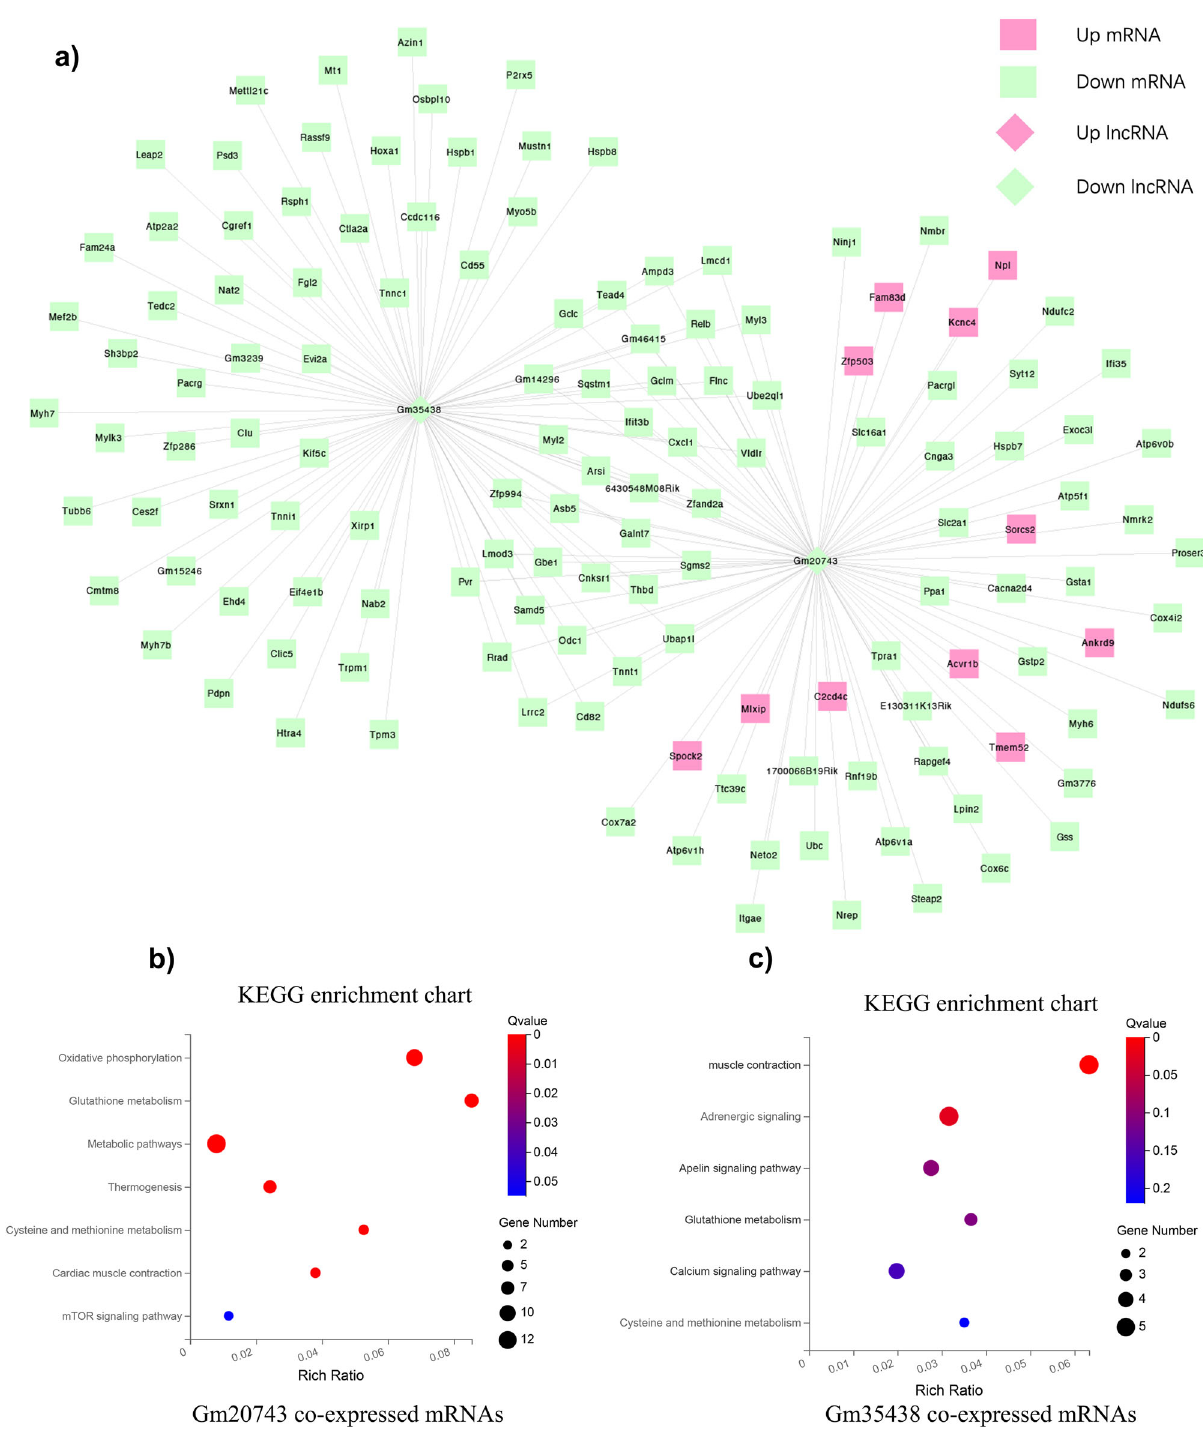
Fig. 7 Co-expression network analysis and functional prediction of lncRNA Gm20743 and Gm35438. a The lncRNA Gm35438 and Gm20743 and 137 mRNAs were constructed in a co ‐ expression network with a PCC > 0.95. The red color represents upregulated genes, and the green color indicates down- regulation expression. Moreover, the top signi fi cant pathway terms of dysregulated genes associated with Gm35438 and Gm20743were displayed according to KEGG analysis ( b , c ), respectively. Note: PCC: Pearson correlation coef fi